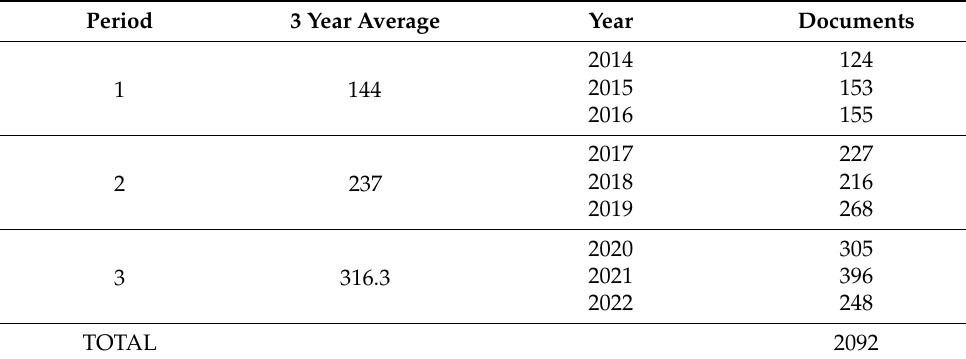
Table 12. SCOPUS documents published on EI (2014–2022).